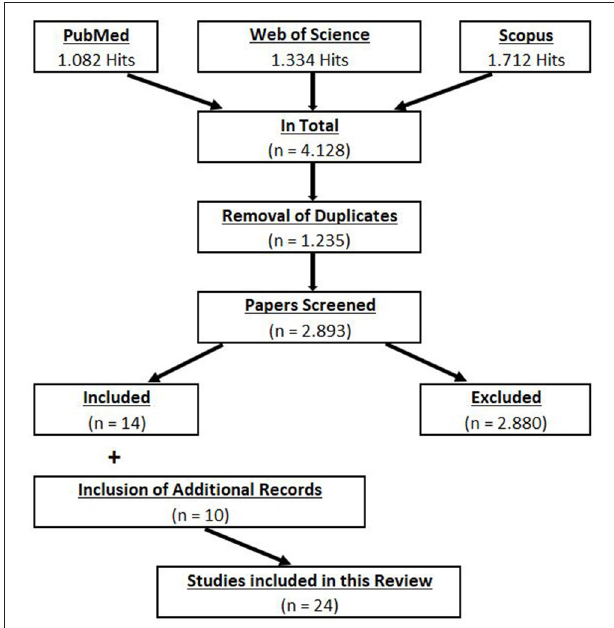
FIGURE 2 | Flowchart of the systematic screening process (Preferred Reporting Items for Systematic Reviews and